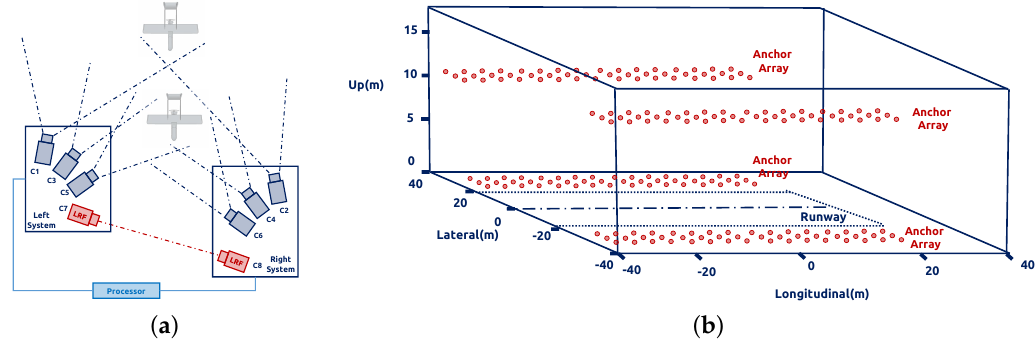
Figure 2. ( a ) Architecture of the multi-camera network. ( b ) In the longitudinal direction, there are 20 anchors separated by 3 m. In the vertical direction, the anchors are either located on the ground or at the 10-m height antennas. The red points show the 240 possible anchor locations.